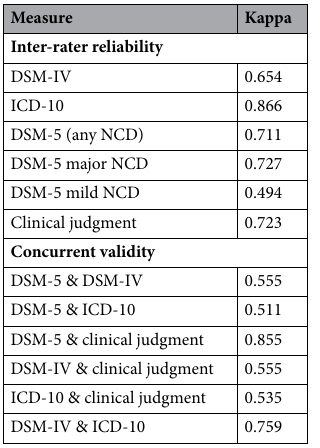
Table 2. Kappa statistic for inter-rater reliability and concurrent validity of each diagnostic criteria and clinical